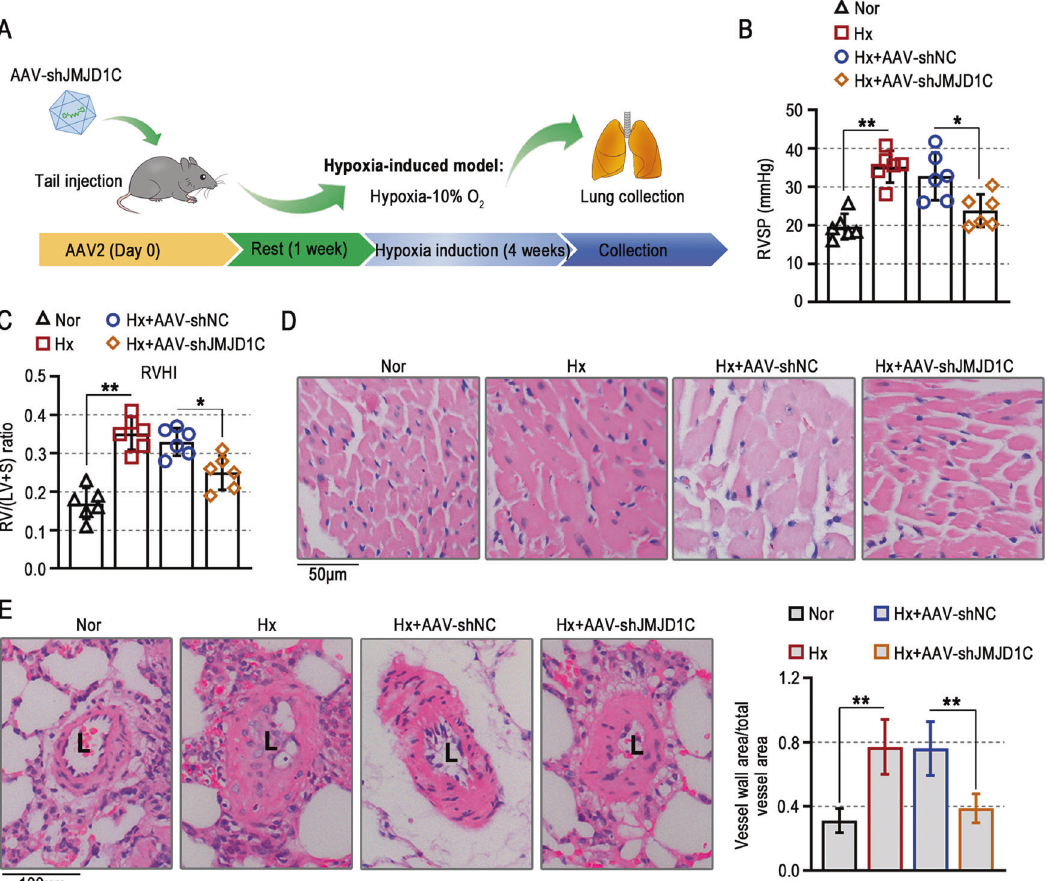
Fig. 2 JMJD1C knockdown attenuates pathological changes in mice exposed to hypoxia. A Illustration of the animal protocols. B , C The RVSP and RVHI in mice exposed to normoxia or hypoxia were examined. D Representative histological images of heart sections stained with H&E. Bar = 50 μ m. E Representative histological images of lung sections stained with H&E. The wall thickness of the pulmonary arteries was measured. Bar = 100 μ m. Nor Normoxia, Hx Hypoxia, L Lumen. The values are the mean ± SD, and statistical signi fi cance was determined by one-way ANOVA. N = 6, * p < 0.05, ** p <